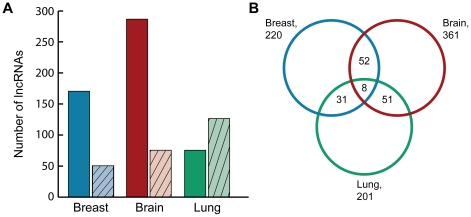
Aberrantly expressed lncRNAs in human cancers.(A) Number of lncRNAs showing significant expression changes. The number of lncRNAs determined to have significant (BH p-value <0.05) differential expression of 2-fold or greater reported. Solid bars indicate upregulated genes, while bars with hatch marks indicate downregulated genes (B) Venn diagram of differentially expressed lncRNAs in human carcinomas.